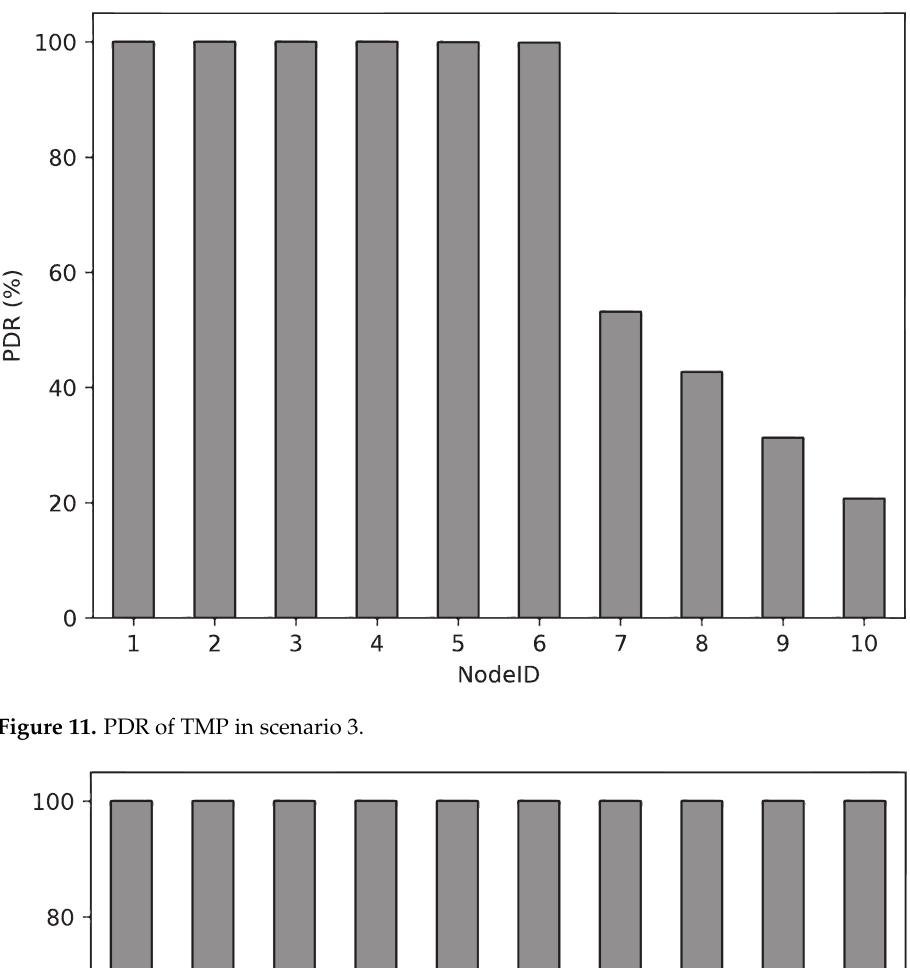
Figure 11. PDR of TMP in scenario 3.